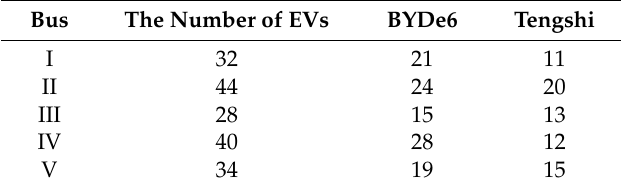
Table 1. The number and type of electric vehicles (EVs) connected to different